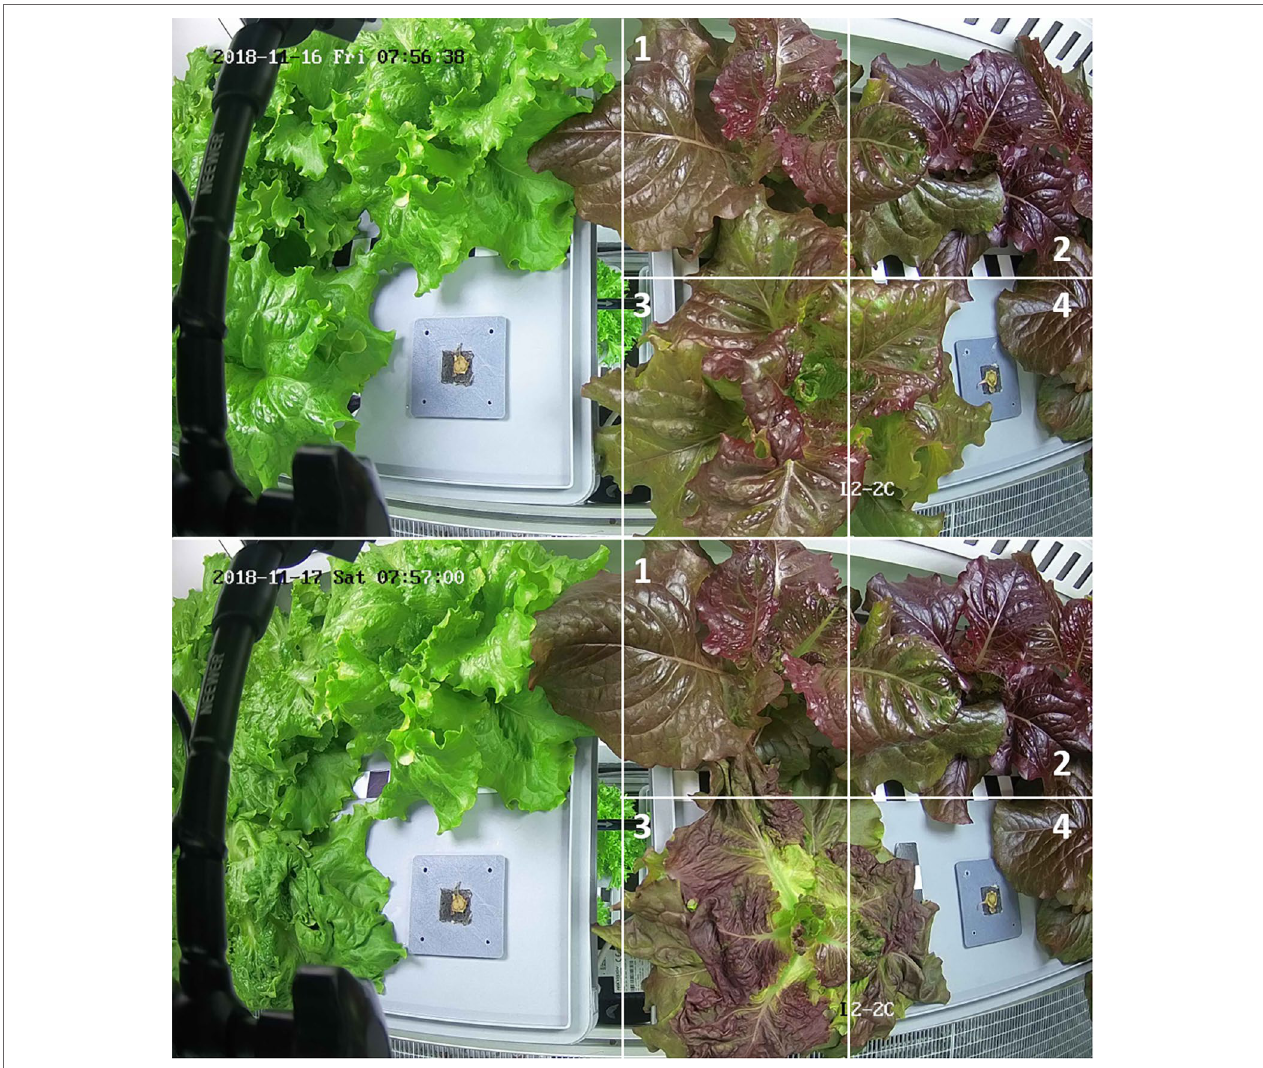
FIGUrE 9 | Images of consecutive days of the two trays monitored by the camera L2-2C; for sake of the simplicity only the sectors of the right tray are drawn. The artificial mistreating of the plant leaves in sector three causes a warning. Note that, in this particular case, no plants are growing in sector four of the right and the left tray.